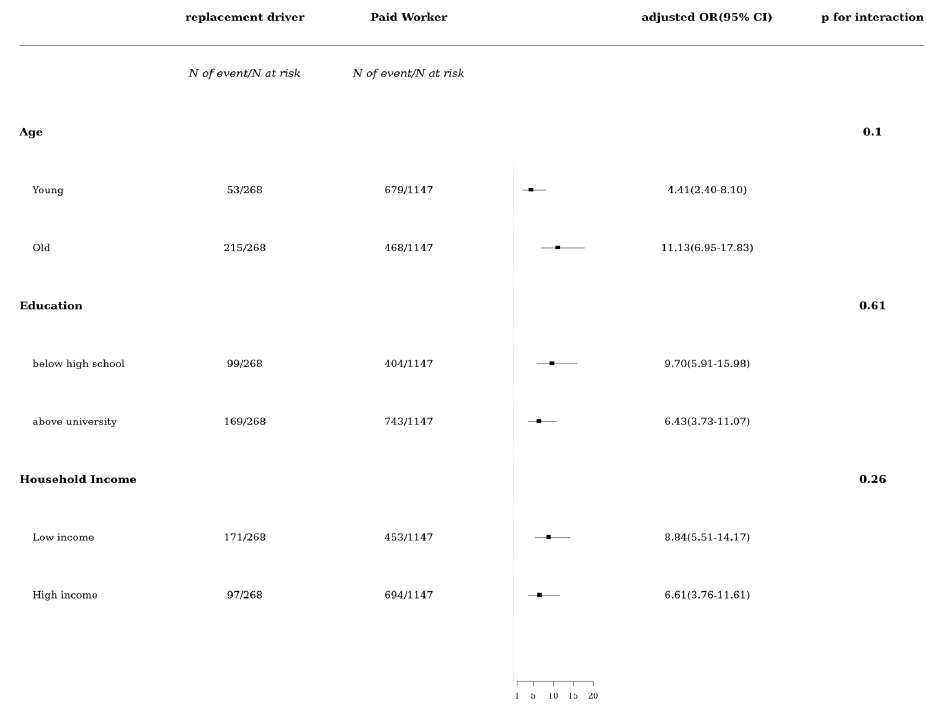
Figure 2. Forest plot of subgroup analysis.